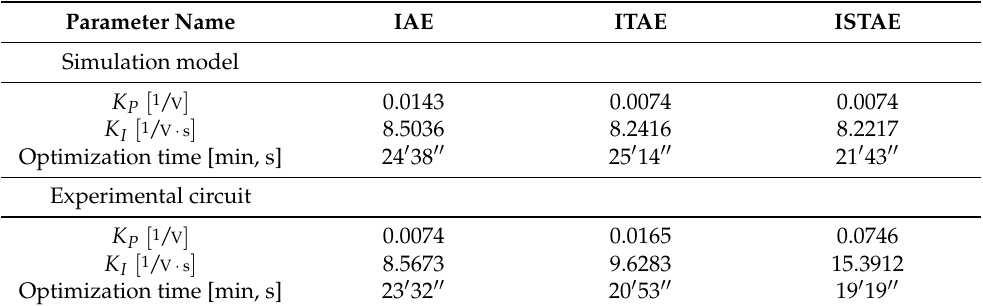
Table 2. Calculated values of PI regulator K P and K I gains together with their computation times by unconstrained GA.